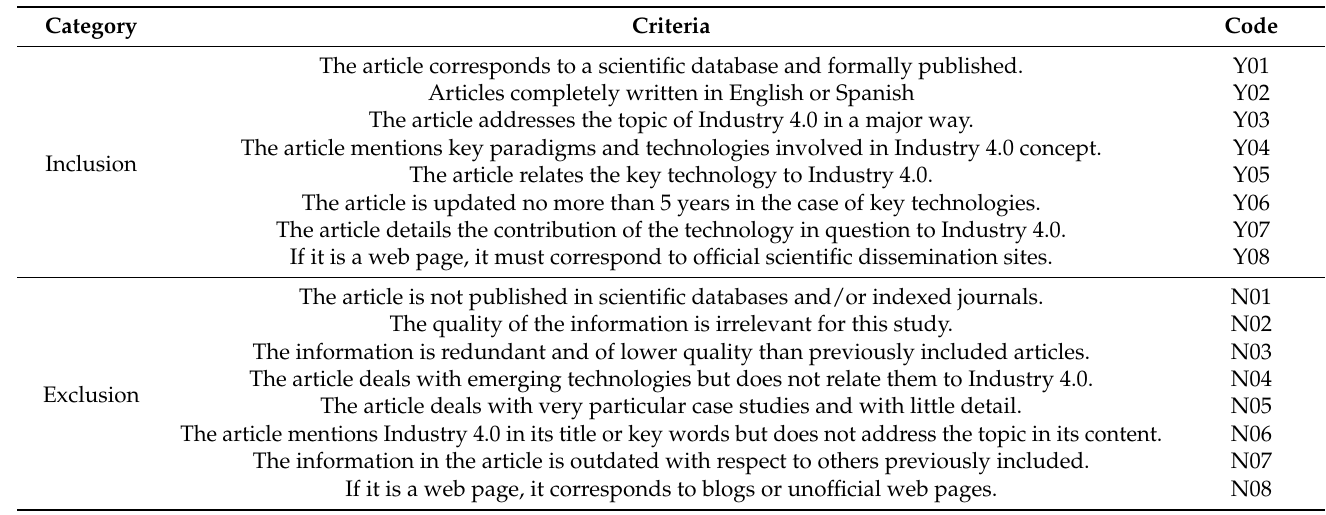
Table 1. Inclusion and exclusion